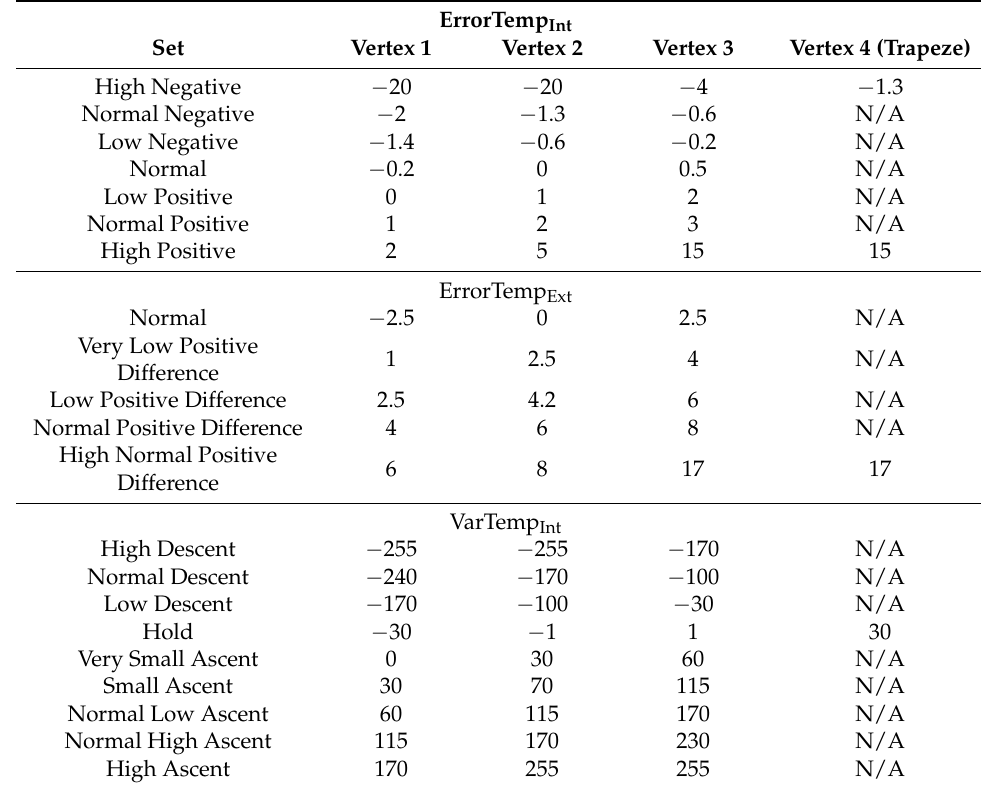
Table 1. Fuzzy sets.